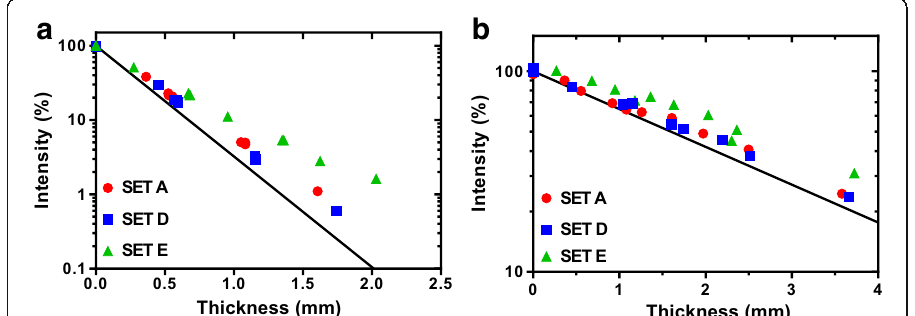
Fig. 8 Beam intensity through different thicknesses of SLM tungsten printed with different scan strategies and different beam intensities a 140 keV, b 364 keV compared to the theoretical ideal (solid